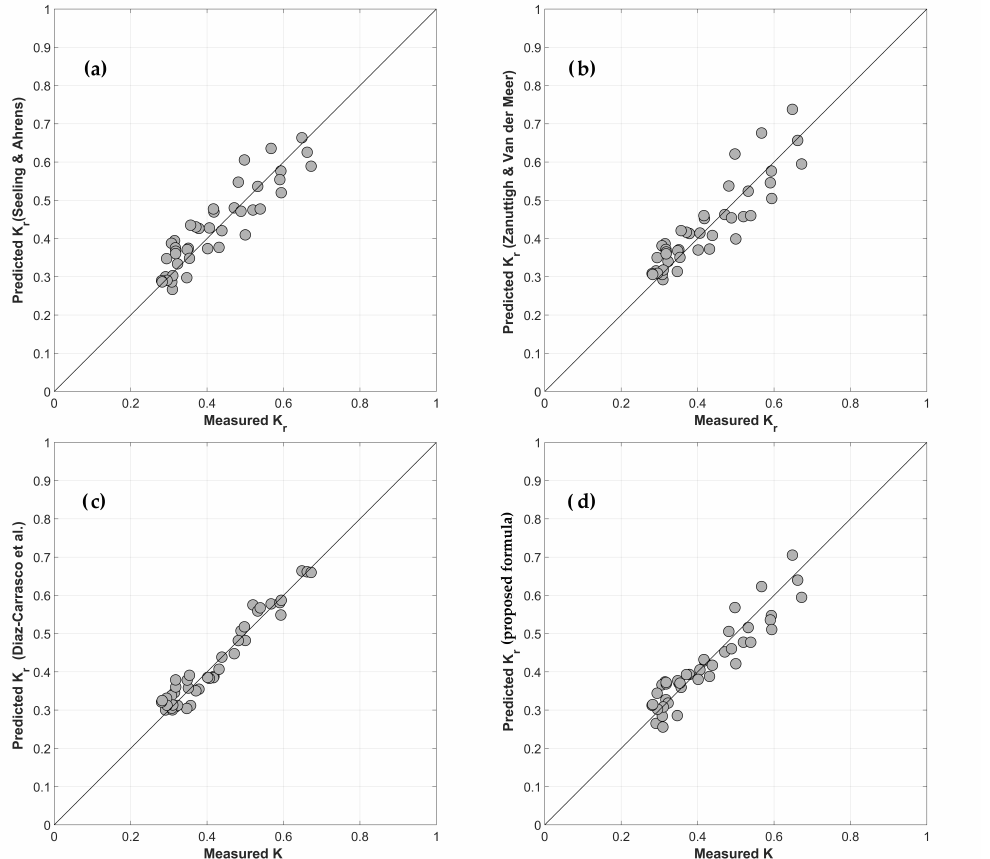
Figure 11. Comparison of predicted and measured reflection coefficient provided by ( a ) Seelig and Ahrens [64], ( b ) Zanuttigh and Van der Meer [63], ( c ) Diaz-Carrasco et al. [66], and ( d ) the proposed